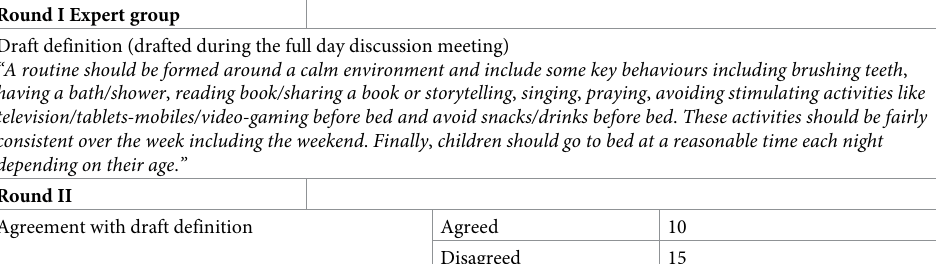
Table 1. Defining bedtime